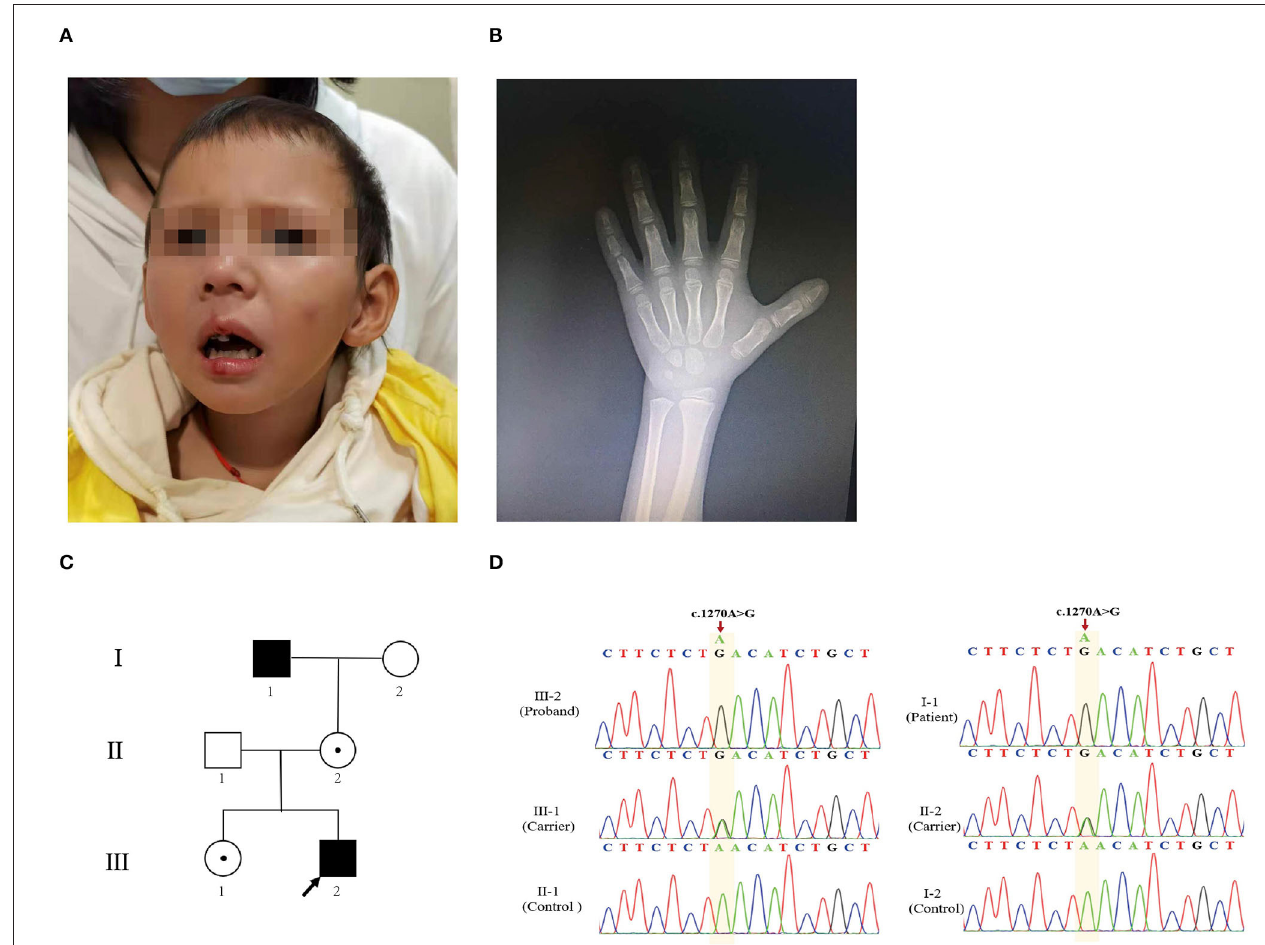
FIGURE 1 | Clinical characteristics of the proband. (A) Image of the proband. Facial abnormalities included triangular face, long philtrum, low-set ears, and short nose. (B) Hand X-ray of the patient. (C) The pedigree analysis and pedigree symbols. The squares and circles refer to males and females, respectively, and the arrow indicates the proband. A filled symbol represents a person affected with AAS, and the center of the black spot circle indicates carrier status. (D) Sanger sequencing chromatogram demonstrates mutation from affected individuals and heterozygous variant from unaffected family